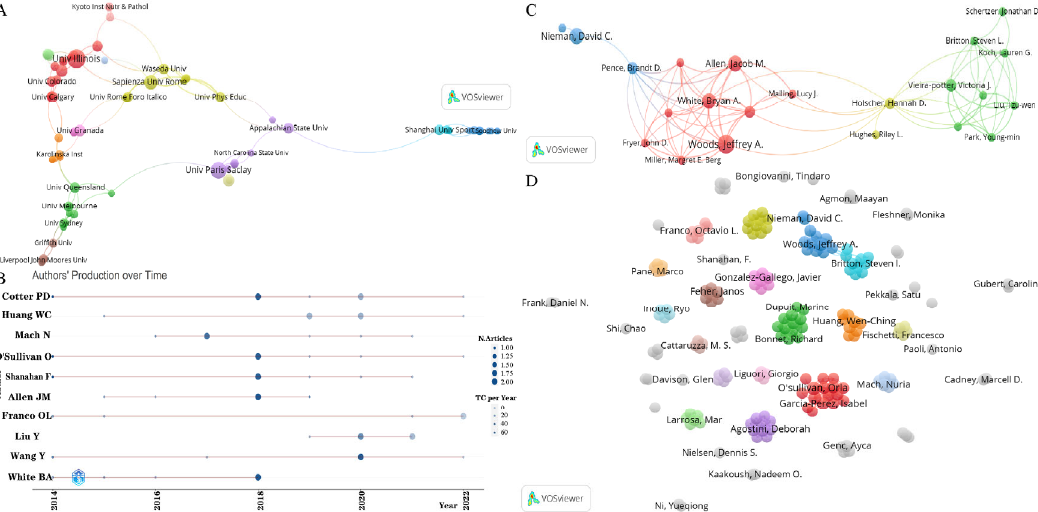
Figure 4. ( A ) Network visualization map of international research collaboration in the microbiome and exercise among the leading active institutions. ( B ) Authors’ production over time, in the field of the microbiome and exercise between 2014 and 2022. ( C ) Network visualization map of authors who connected with each other. ( D ) Network visualization map of all authors. Table 2. Top ten active institutions with the most publications about the gut microbiome and exer ‐ cise.